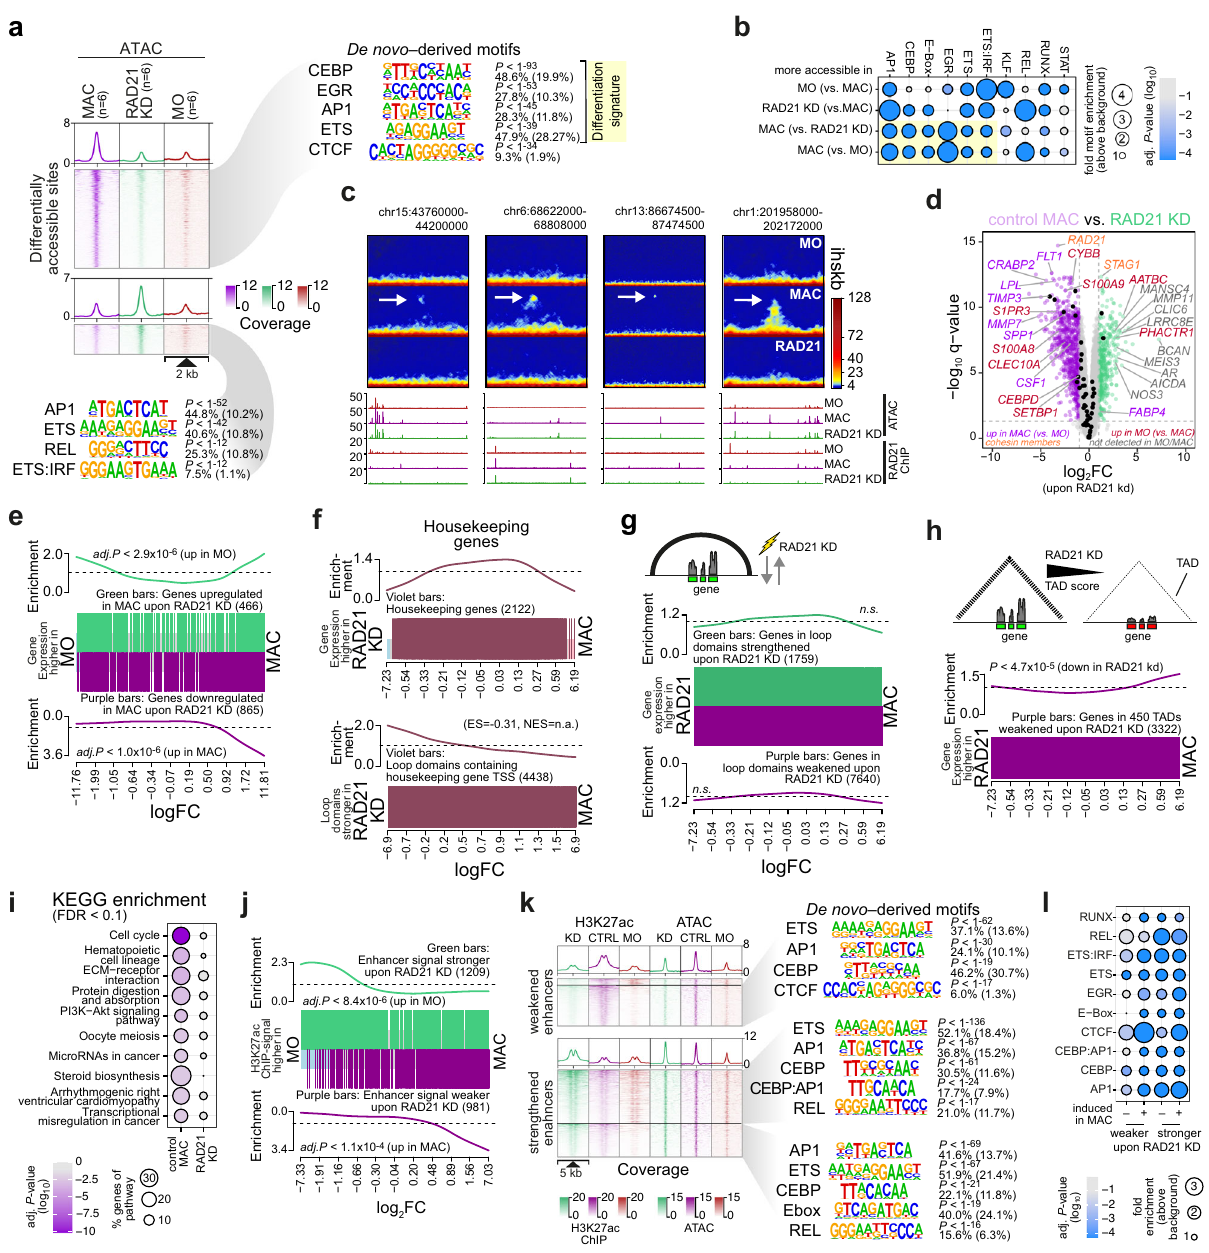
Fig. 8 Loss of cohesin profoundly affects MO differentiation-dependent transcriptional programs. a Distribution of ATAC-seq signals across differentially accessible sites in control MAC, RAD21 siRNA-treated cells as well as freshly isolated MO. Top de novo -derived motifs for each cluster are given (as in Fig. 7b). Signature motifs that are associated with MO differentiation are highlighted. b Comparative enrichment of known TF motifs across differentially accessible chromatin regions of the indicated comparisons. c Comparative in situ Hi-C interaction maps and corresponding genome browser tracks for example regions of differentiation-associated loops. Arrows mark differential loops that were induced upon MO differentiation. d Volcano plot of genes differentially expressed in control versus RAD21 knockdown MAC, as described in Fig. 7c. e Enrichment of genes that were differentially expressed upon RAD21 KD across all genes ranked by their signal in MO versus MAC. f Analysis of housekeeping genes. Top panel: Gene set enrichment of all genes ranked by their signal in siRNA-treated versus control MAC. Bottom panel: loop set enrichment for domains containing housekeeping genes across all loop domains ranked by their score in siRNA-treated versus control MAC (ES, enrichment score; NES, normalized enrichment score; P not determined due to unbalanced gene-level statistics). g Enrichment of genes in altered loop domains across all genes ranked by their signal in siRNA-treated versus control MAC. h Gene set enrichment of genes in weakened TADs across all genes ranked by their signal in siRNA-treated versus control MAC. i KEGG pathway analysis of genes affected by RAD21 loss in moDC. j Enrichment of H3K27ac-marked regions affected by RAD21 KD across all enhancers ranked by their signal intensity in MO versus MAC. k Genomic distance distributions of H3K27ac and ATAC signals at differential H3K27ac peaks, centered on overlapping open chromatin. Top de novo -derived motifs are presented as in ( a ). l Motif enrichment across open chromatin associated with H3K27ac peak regions as indicated. P -values were determined using hypergeometric tests in ( a , b , i , k , l ) or two-sided rotation tests in ( e , g , h , j ) and adjusted for multiple testing (BH correction) except in ( a , h , k ). ( a , b , i , k , l ) Source data are provided as a Source Data fi